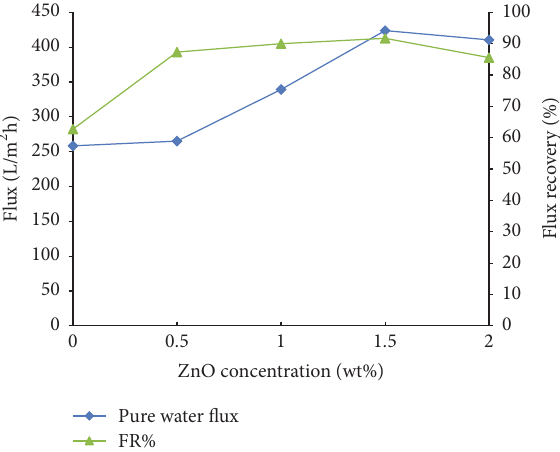
Figure 6: Pure water flux and flux recovery, FR% (after filtration of BSA) changes with the addition of ZnO